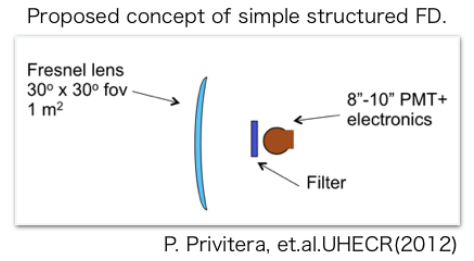
Figure 2. The concept of a simple structure Fresnel lens tele- scope for UHECR